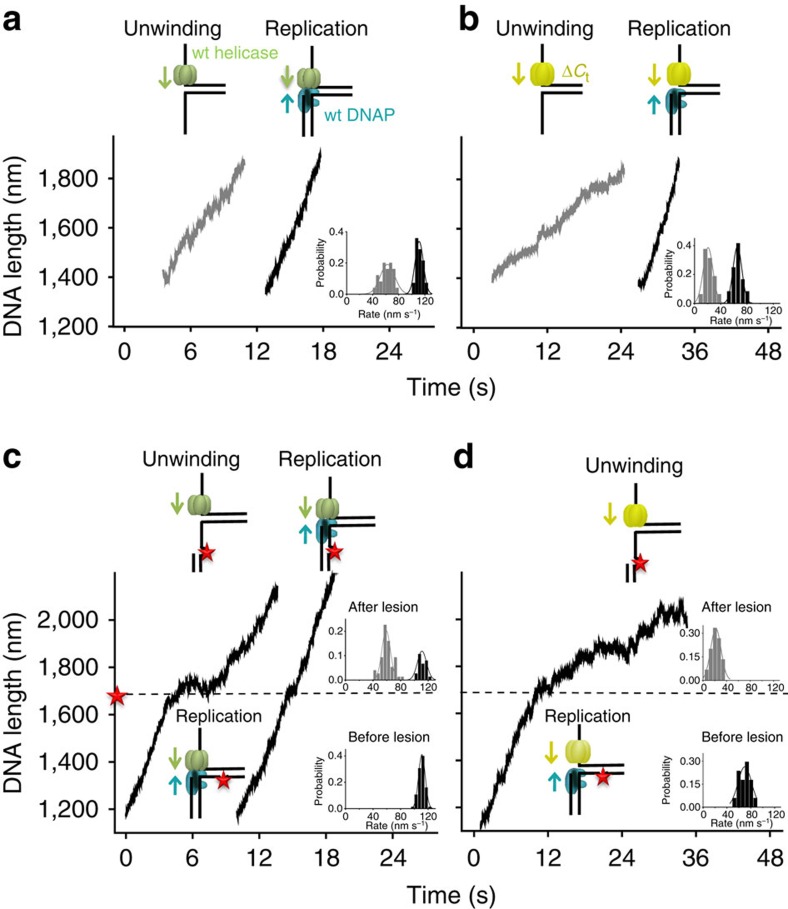
Single-molecule experiments of leading-strand synthesis on a DNA template containing a CPD lesion in the presence of helicase.(a,b) Helicase unwinding and helicase/DNAP-coupled leading-strand replication on an unmodified DNA template. The helicase's and DNAP's activities were monitored as changes in the DNA length. Representative traces showing DNA length versus time for wt (a) or ΔCt (b) helicase unwinding and a wt DNAP with wt (a) or ΔCt (b) helicase replication in the presence of 0.5 mM dNTP (each) under 6 pN. For clarity, traces have been shifted along the time axis. Cartoons illustrate different protein compositions at the fork for each trace. Insets display distributions of DNA length increase rates for each condition. (c,d) Helicase/DNAP-coupled leading-strand replication on a DNA template containing a single CPD lesion (red star). Representative traces showing DNA length versus time for a wt DNAP with either a wt helicase (c) or a ΔCt helicase (d) in the presence of 0.5 mM dNTP (each) under 6 pN. The dotted lines indicate the position of a single CPD lesion. For clarity, traces have been shifted along the time axis. Cartoons illustrate different protein compositions at the fork before and after the lesion for each trace. Insets display the distributions of DNA length increase rates before and after the lesion.